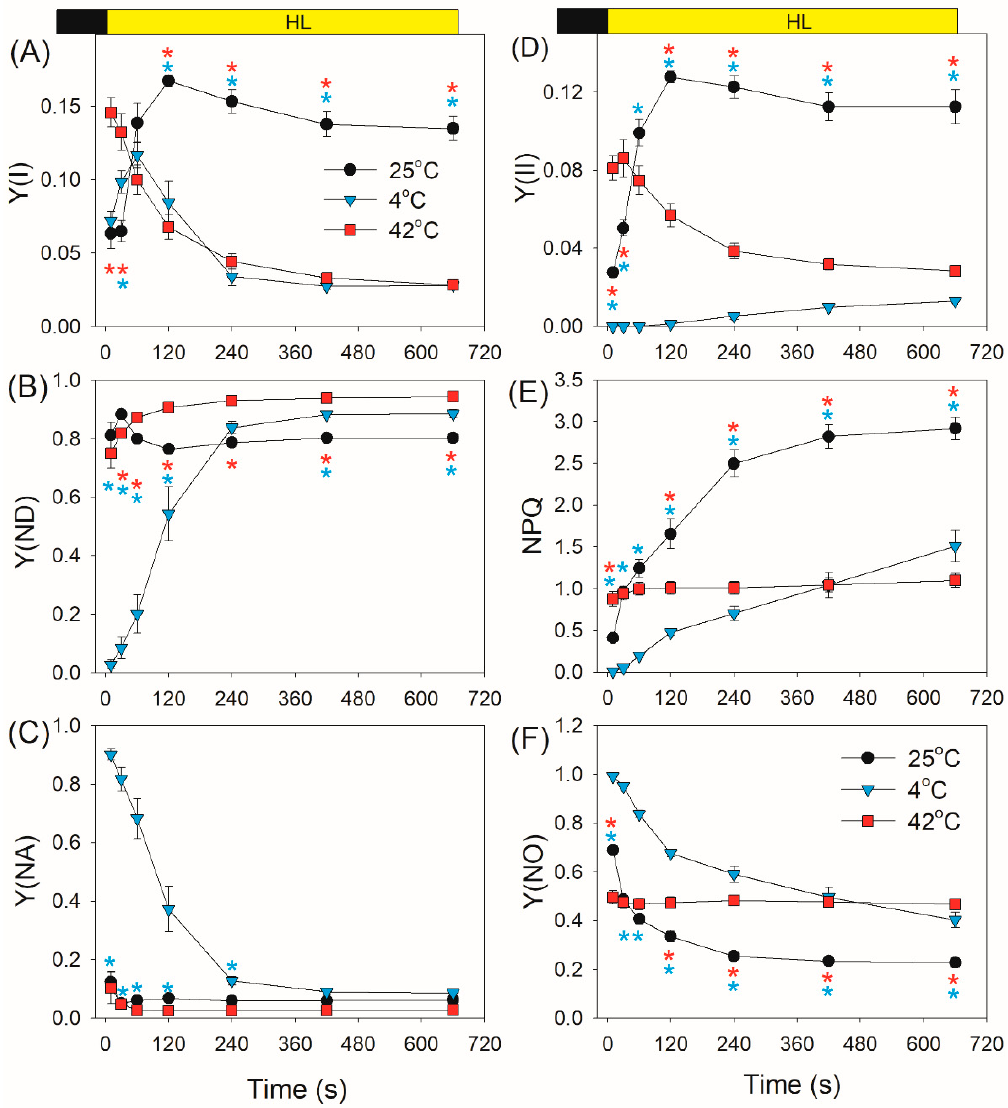
Figure 2. Changes in photosystem (PS) I and PSII parameters after transition from dark to actinic light (1455 µ mol photons m − 2 s − 1 ) at 25 °C, 4 °C, and 42 °C. ( A – C ) Y(I) represents the quantum yield of PSI photochemistry; Y(ND), the quantum yield of PSI non-photochemical energy dissipation due to the donor side limitation; Y(NA), the quantum yield of the non-photochemical energy dissipation due to the acceptor side limitation. ( D – F ) Y(II) represents the effective quantum yield of PSII photochemistry; NPQ, non-photochemical quenching in PSII; Y(NO), the quantum yield of non-regulated energy dissipation in PSII. Values are means ± standard error (SE) ( n = 5). Red asterisks indicate significant differences between 25 °C and 42 °C, and blue asterisks indicate significant differences between 25 °C and 4 °C.